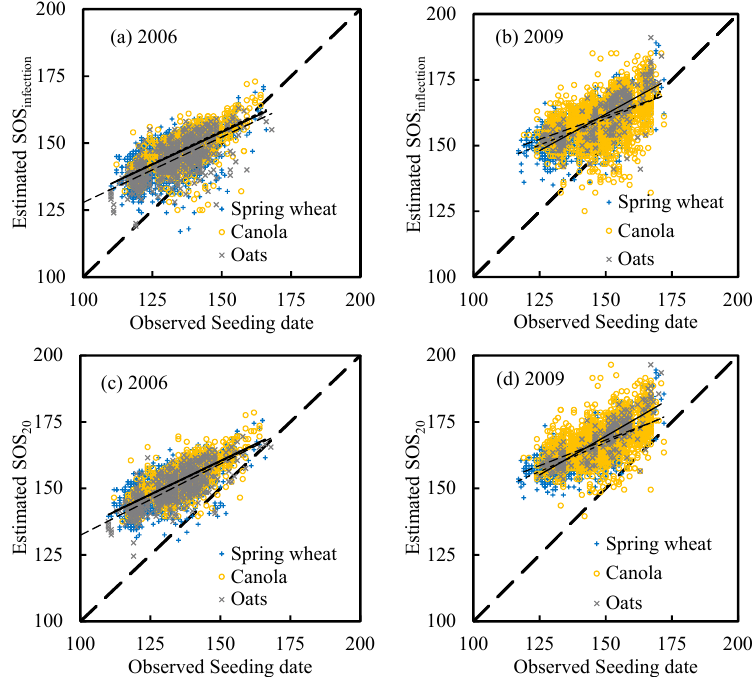
Figure 4. Scatter plot of observed seeding date and remotely sensed SOS for different years: 2006 ((a) and (c)) and 2009 ((b) and (d)); DOY is the day of year, and the dashed black line denotes the 1:1 lines.